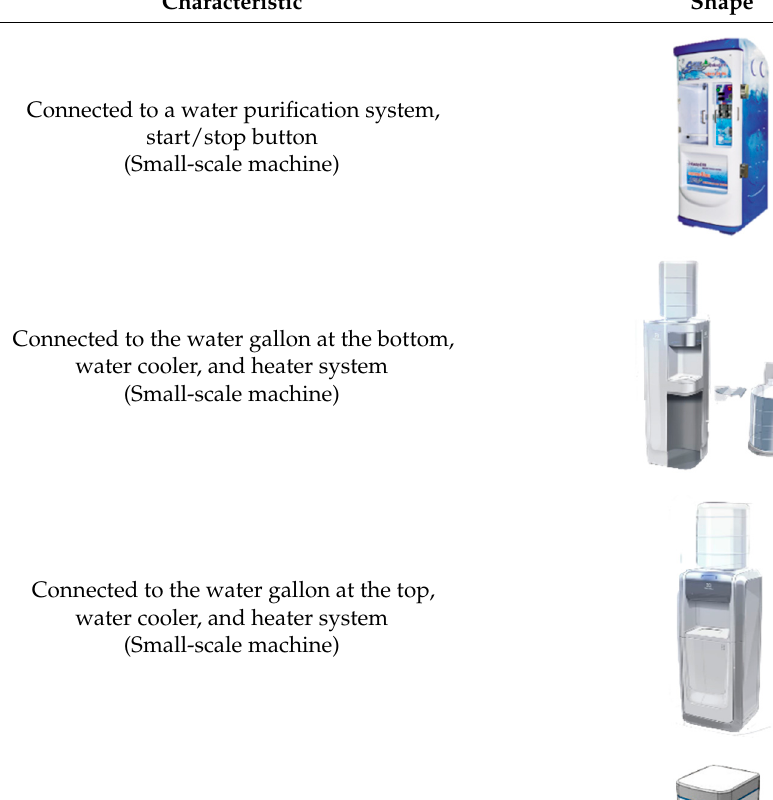
Table 1. Market survey on the automatic water filling machine.